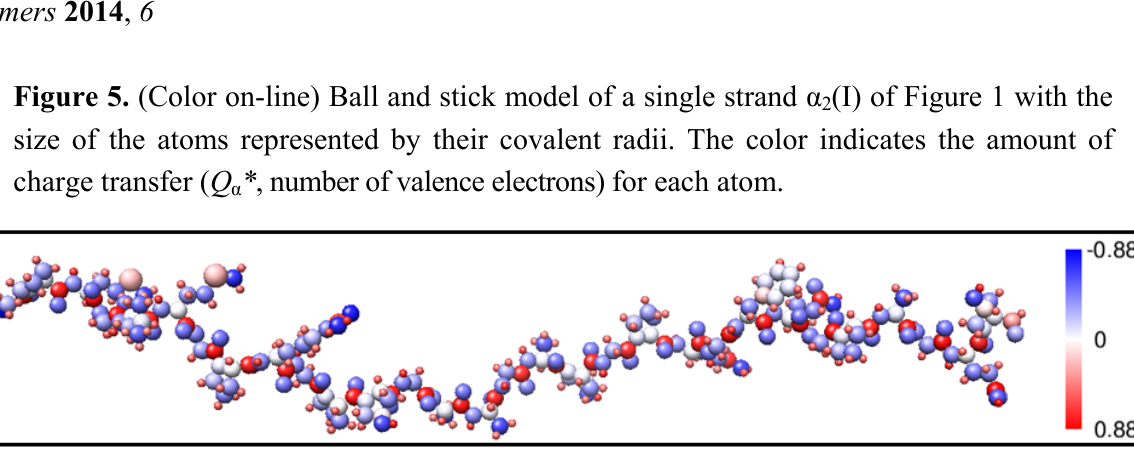
(I) of Figure 1 with the 2